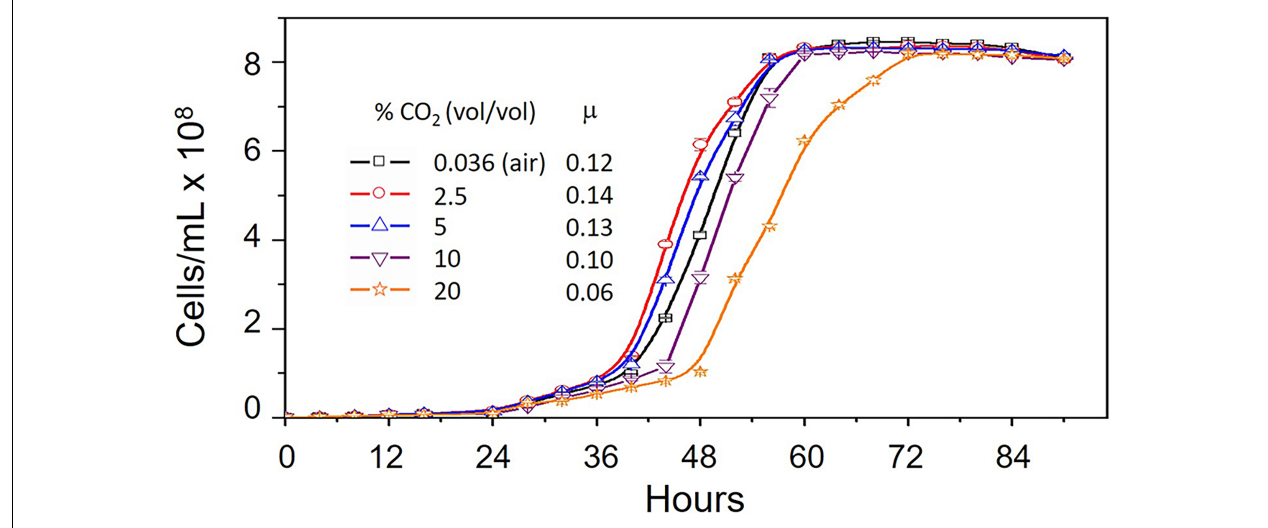
FIGURE 1 | Growth curves of Acidithiobacillus ferrooxidans grown in 9K medium supplemented with 5 g/L elemental sulfur at 30 ◦ C in increasing concentrations of CO 2 from 0.036% (vol/vol) (air) to 20% (vol/vol). Ranges are shown for duplicate measurements. µ = growth rate (hr - 1